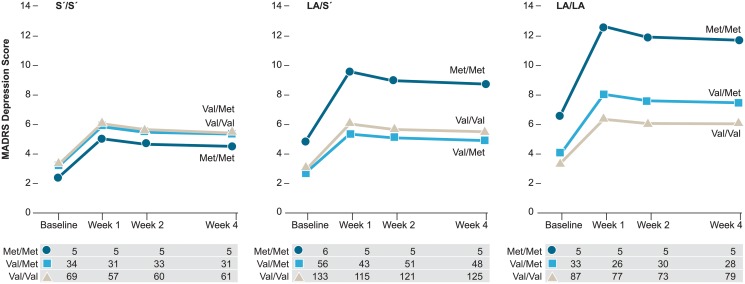
Predicted values for the interaction effect between brain-derived neurotrophic factor (BDNF) and serotonin transporter gene-linked polymorphic region, 5HTTLPR-rs25531. Within hip fracture participants with two 5HTTLPR-rs25531 LA alleles (LA/LA), contrast results for the GEE analysis indicate BDNF Met/Met carriers had significantly higher depressive symptoms than Val/Val carriers (χ2 = 4.37(1), p = .037) and Val/Met carriers (χ2 = 3.86(1), p = .05). Sample sizes are listed below each graph. Abbreviations: MADRS, Montgomery-Asberg Depression Rating Scale; GEE, Generalized estimating equations.